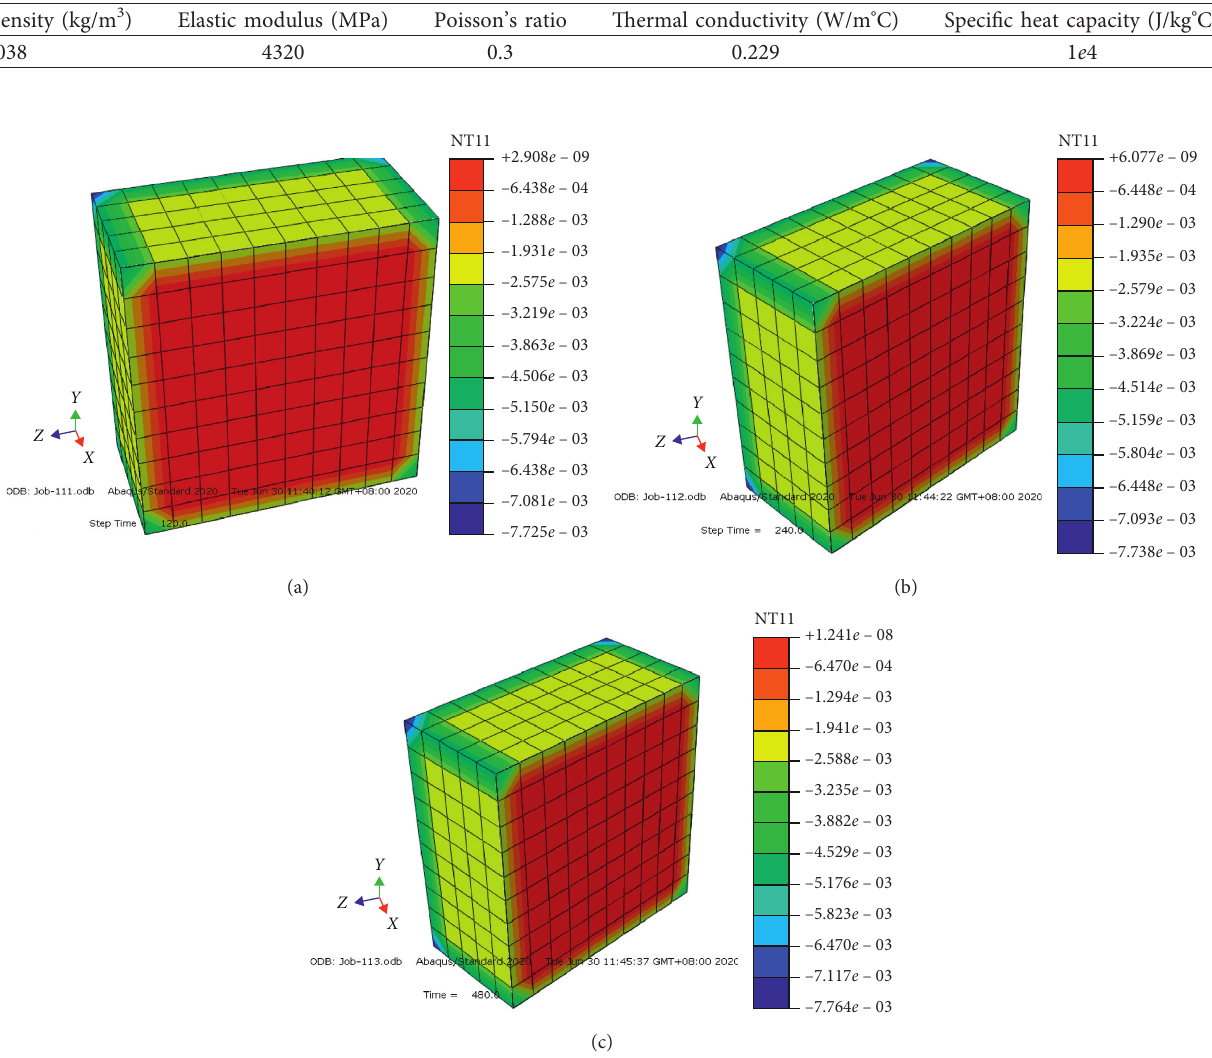
Table 1: The physical parameters of the rock.